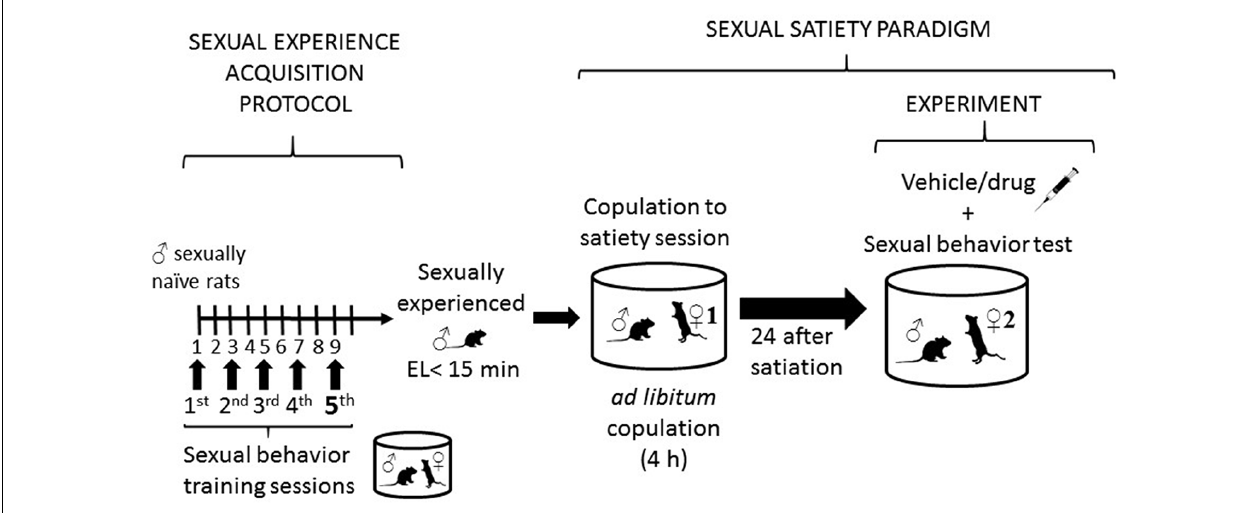
FIGURE 1 | Description of sexual behavior protocols. The left side of the figure describes the protocol followed to render sexually experienced male rats, consisting in subjecting sexually naïve rats to five independent sexual behavior sessions, run every other day. At the end of this process males showing ejaculation latencies (EL) shorter than 15 min are considered sexually experienced and selected for the study. The right side of the figure describes the sexual satiety paradigm, involving sexually experienced male rats that copulate ad libitum with a single sexually receptive female ( 1) until reaching the sexual satiety criterion (around 4 h). Twenty-four hours later these males receive the pharmacological treatment or its vehicle and are subjected to a sexual behavior test with a new sexually receptive female ( ♀ ♀